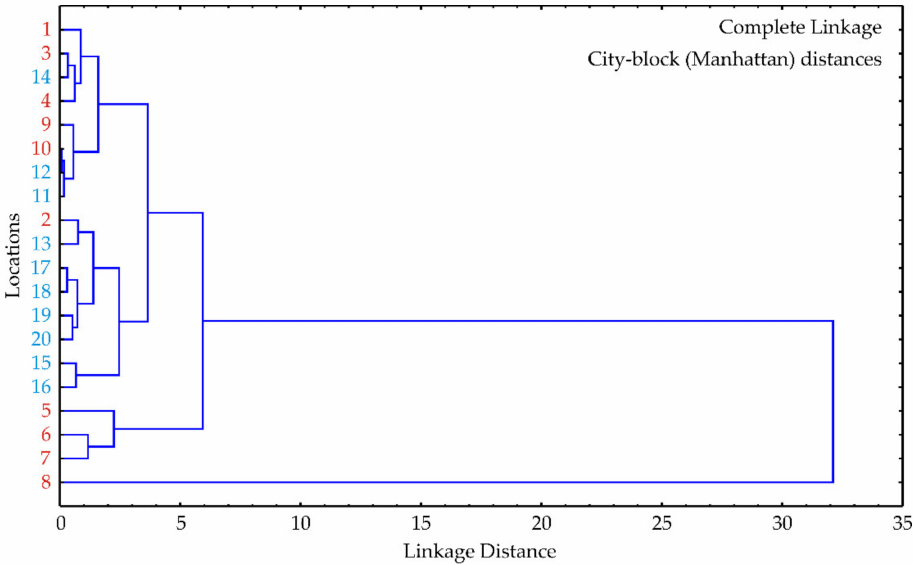
Figure 7. Cluster analysis of DMC, ESA, and OA concentrations detected in water samples from sampling sites in the Danube River and Tisza River.